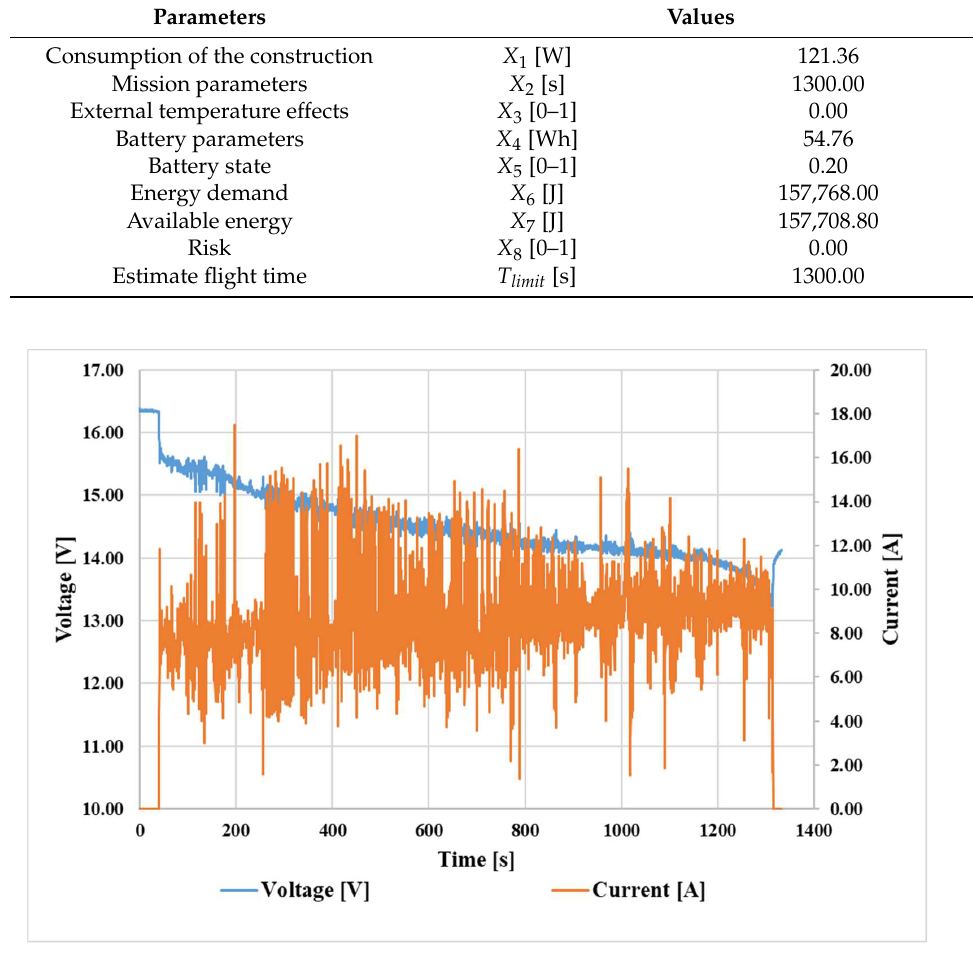
Figure 8. In-flight monitored voltage and current measurements. Figure 8 shows the voltage in blue and the current in red. The average load was 8.2 A, corresponding to 2.2C. In Figure 9, the variation of the voltage and the SOC can be found.